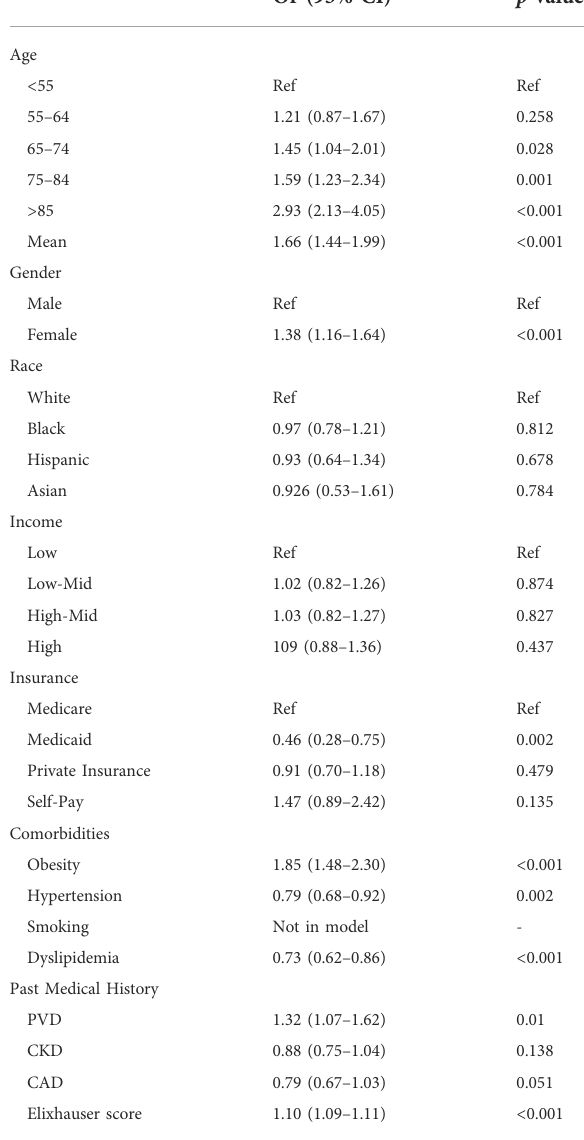
TABLE 3 Multivariable regression of in-hospital mortality among diabetes patients with heart failure and hypertrophic